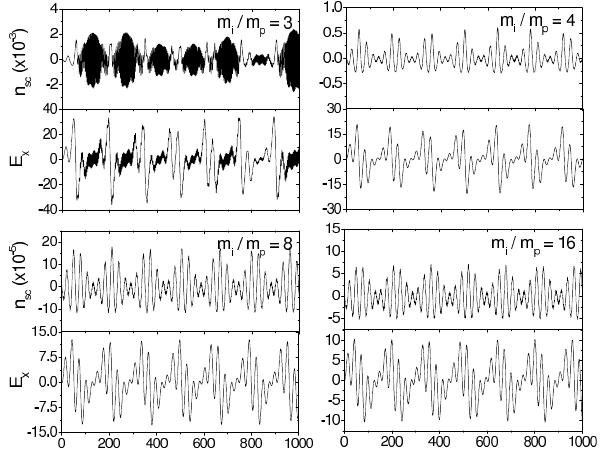
Fig. 16. Same as Fig. 13 but the impact of ξ v = V T oscilliton waves. Notice that the panels of V T case discussed in the last